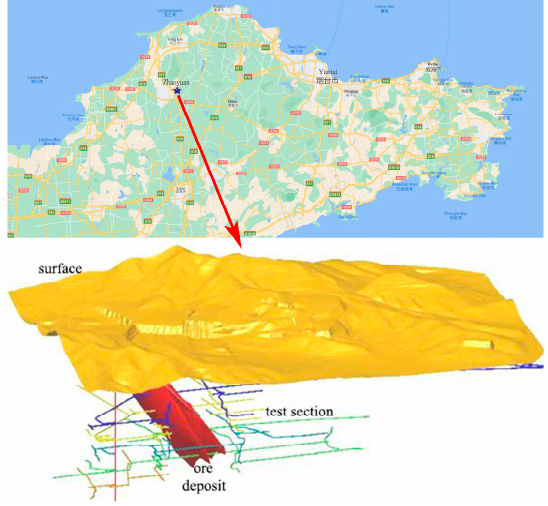
Figure 1. Schematic diagram of the location of the L mining area in Shandong Province.